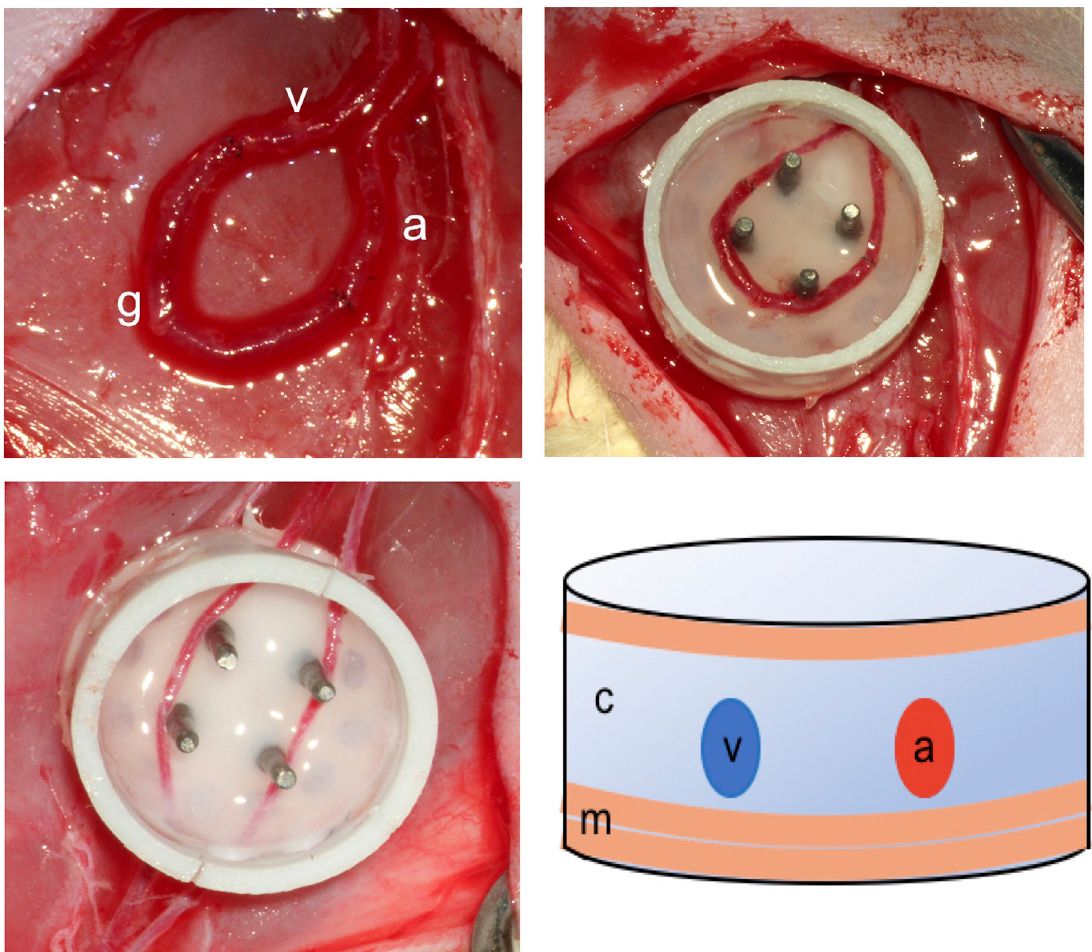
Fig 1. Above left: AV loop: venous graft (g) saphenous artery (a), saphenous vein (v), above right: AV loop in the chamber, below left: AV flow-through vessels passing uninterrupted through the chamber, below right: diagrammatic illustration of a cross section of the construct; a: arterial side of the vascular axis, v: venous side, c: collagen clot, m: Matriderm, 2 layers below and one layer above the vessels. were performed on the same day of cell injection, i.e. 12 days after construct implantation. Under general inhalational anesthesia, syngeneic donor male Lewis rats (age 5–6 weeks) were euthanized by intra-cardiac injection of 1 ml phenobarbital (Narcoren, Boehringer Ingelheim, Ingelheim am Rhein, Germany). The tibia and femur were excised from both legs, and the bone marrow was flushed out with 20 ml bone marrow mesenchymal stem cell (BMSC) cul- ture medium under aseptic conditions. The mononuclear cells were isolated from the bone marrow via density gradient using ficoll medium (Ficoll-PaqueTM plus, GE Healthcare, Swe- den) [17]. The cells were then suspended in 1000 μ l of BMSC cell culture medium. To deter- mine the cell concentration in the isolate, 1 μ l of this cell suspension was mixed with 99 μ l of a trypan blue solution (Carl Roth, Karlsruhe, Germany) diluted to 1:100, incubated for three minutes at room temperature and applied to the counting chamber (C-Chip Neubauer, Carl Roth, Karlsruhe, Germany). The vital cells not acquiring the stain were counted within the C-Chip under the microscope to determine the cell concentration in 1 μ l of the cell isolate. Fol- lowing the manufacturer protocol, Qdot 1 655 nanocrystals (InvitrogenTM / Thermo Fisher Scientific, Germany) were used to label the fresh isolated cells at a concentration of 10 nM